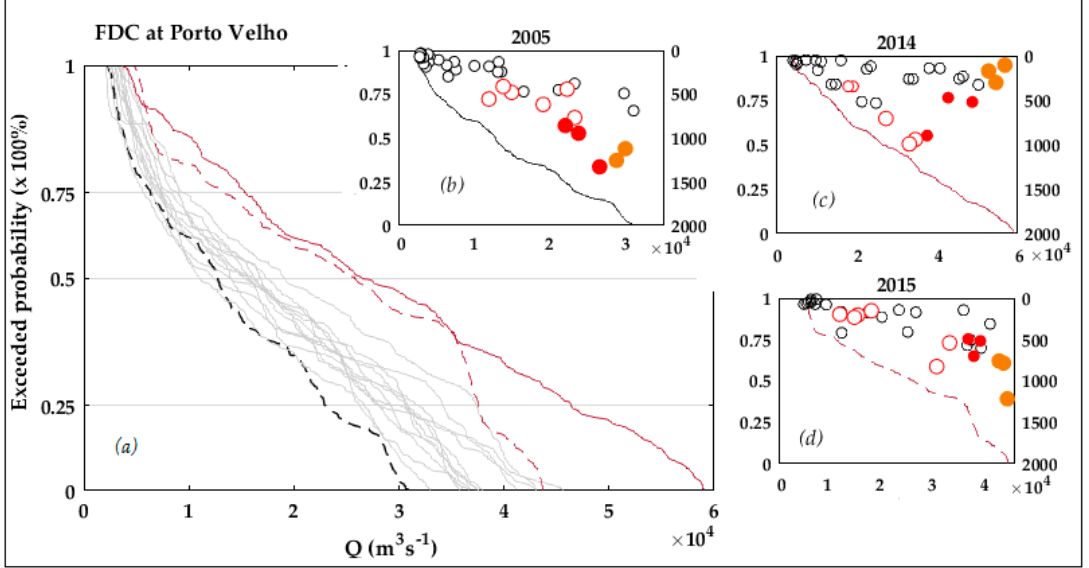
Figure 3. ( a ) Flow duration curves (FDC) for the hydrological years 2003–2017 at Porto Velho (PV) in the Madeira River. The red line indicates the flood event from 2013 to 2014. The black line indicates the 2005 drought and the red dashed line represents 2014–2015. FDC: ( b ) for the 2005 drought within each measured surface suspended sediment (SSC) by SO-HYBAM as empty black circles, ( c ) for the 2014 flood event, and ( d ) for 2015. December and January are represented with a red border. February is represented by red circles. March is represented in orange. For the inside figures, the left y-axis shows the exceeded probability in percentages, and the right y-axis shows the SSC in mg · L − 1 .